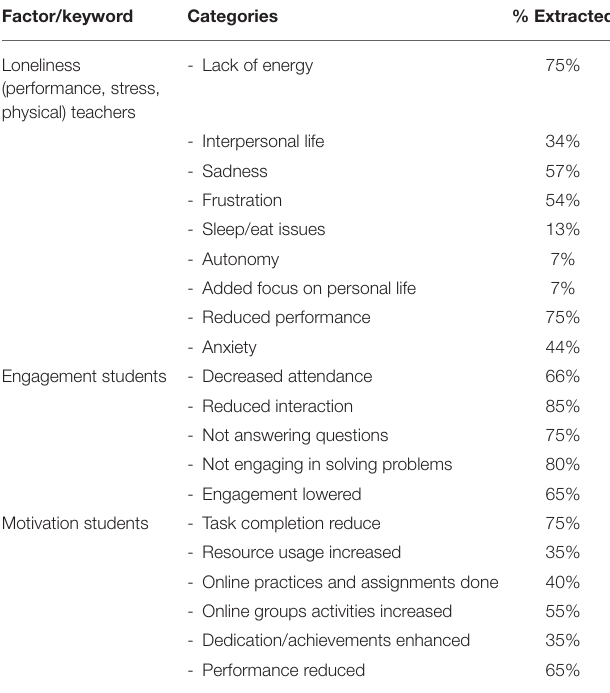
TABLE 1 | Participants’ profile. Factor Count Total Age range Min 30/Max 59 20 Experience Min 2/Max 25 20 Gender Female 13/Male 7 20 Number of students during Min 145/Max 220 + pandemic classes (approx.)